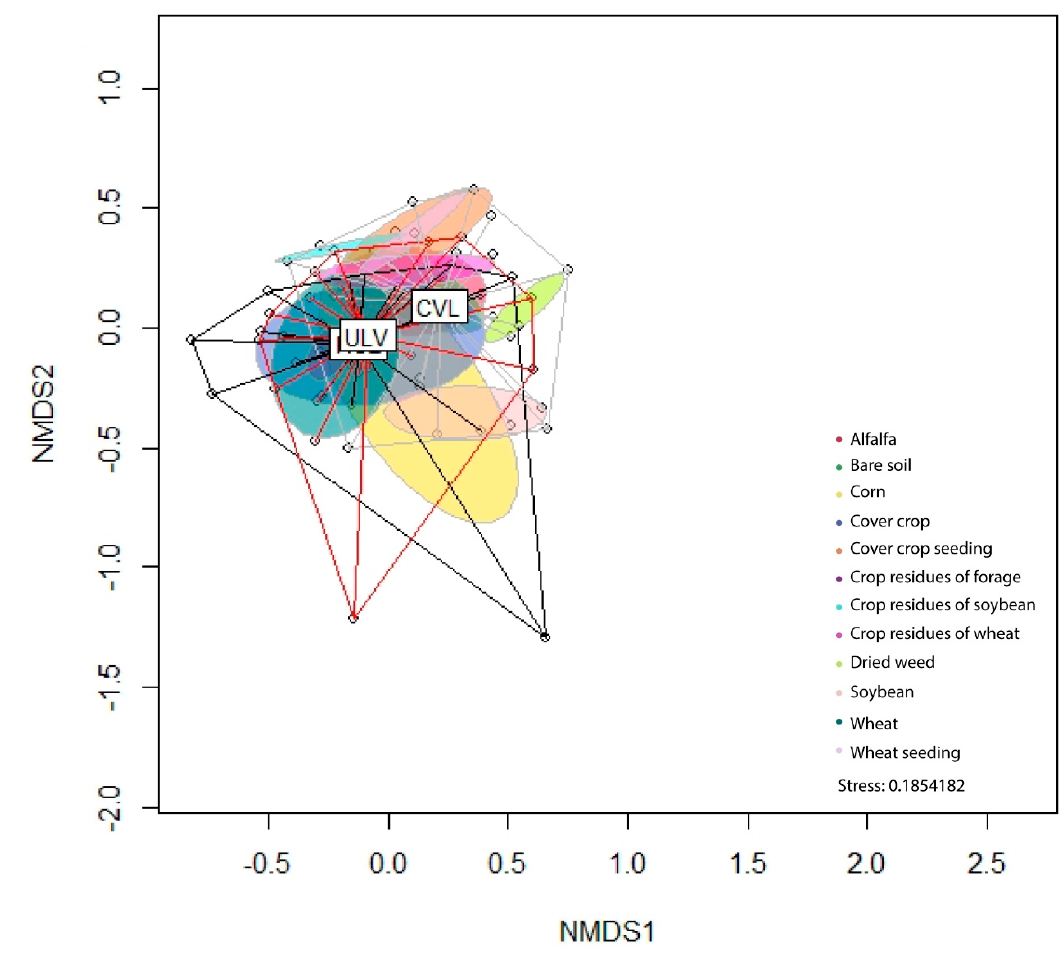
Figure 2. Bray-Curtis based NMDS plot of the arthropod community composition. Points represent samples. “Spider” diagrams connect each point to the belonging farm: ROZ: Ruozzi farm, in black, ULV: Gli Ulivi farm, in red, and CVL: Cavallini farm, in grey. Ellipses represent crop variables.